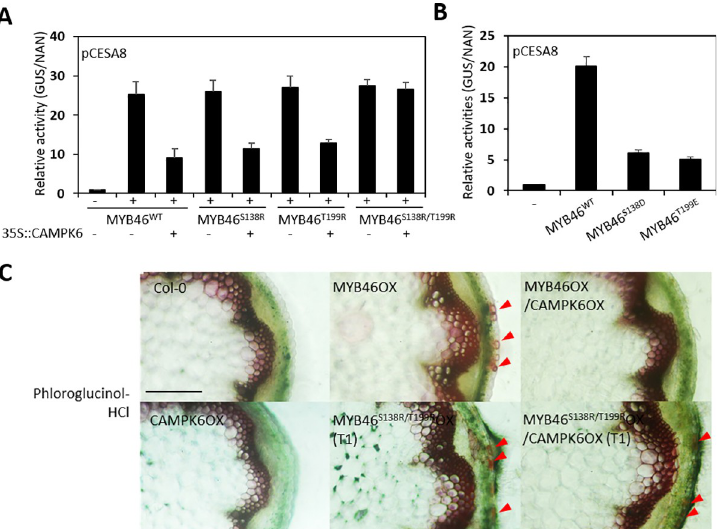
Fig 5. Phosphorylation sites of MYB46 is important for in planta MYB46 activity. (A) pCESA8:: GUS was expressed with MYB46 or its non-phosphorable mutants (MYB46 S138R , MYB46 T199R , or MYB46 S138R/T199R ) with or without CAMPK6 in AMPs. After 6-hr incubation, the cells were harvested for measurement of GUS activity. NAN was used as expression control. (B) pCESA8:: GUS was expressed in AMPs with MYB46 or its phospho-mimic mutants (MYB46 S138E or MYB46 T199D ). After 6-hr incubation, GUS activity was measured and NAN was used as expression control. (C) Lignin staining of stem sections. Phloroglucinol-HCl staining was performed on the rosette-level stem sections of 8-week-old Col-0 plants, transgenic plants overexpressing MYB46 (MYB46OX), MYB46 and CAMPK6 (MYB46OX/CAMPK6OX), non-phosphorable mutant (MYB46 S138R/ T199R OX, T1), or MYB46 S138R/T199R and CAMPK6 (MYB46 S138R/T199R OX/CAMPK6OX, T1). Red arrowheads indicate ectopic lignifications. Scale bar, 100 μ m.